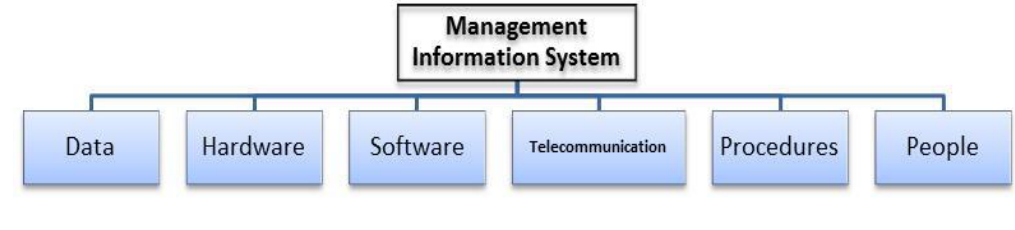
Fig. 17. Management information system.